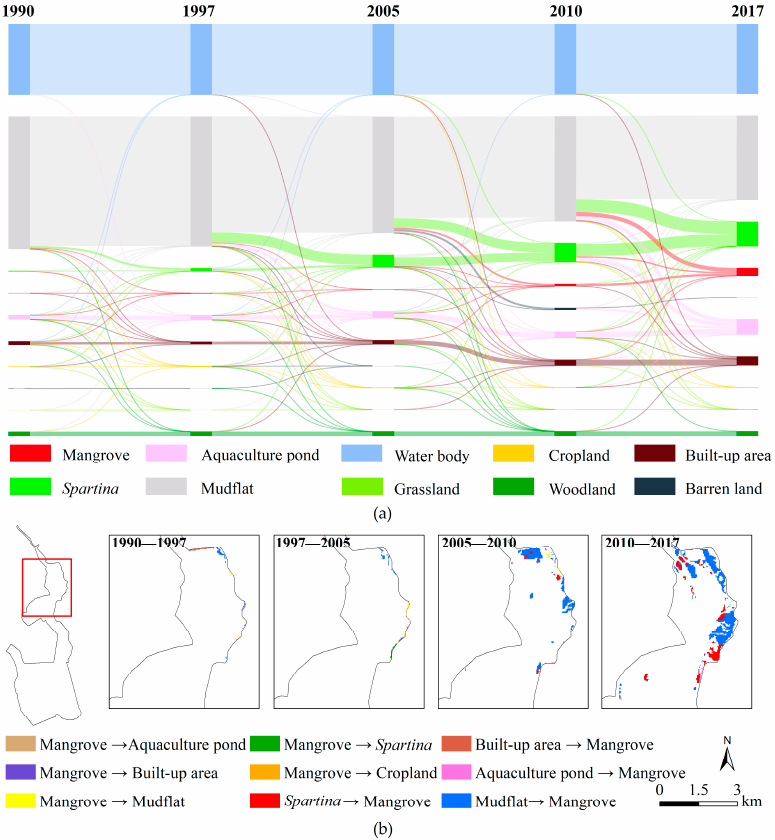
Figure 6. Comparisons of land cover dynamics. ( a ) Sankey diagram for comparison of total land cover dynamics from 1990 to 2017; ( b ) spatial distribution of conversion between mangrove forests and other land cover types in four time intervals from the years 1990, 1997, 2005, 2010, and 2017.